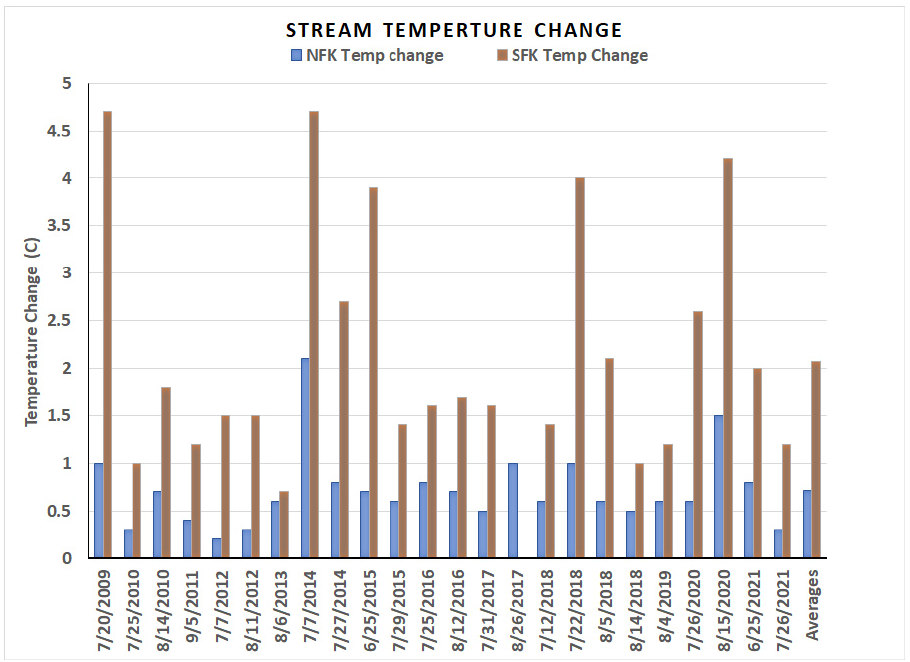
Figure 5. Change in daily stream temperature in the North Fork Nooksack (NFK) and South Fork Nooksack (SFK) during the 23 heat events from the beginning of the period to the maximum observed daily temperature.